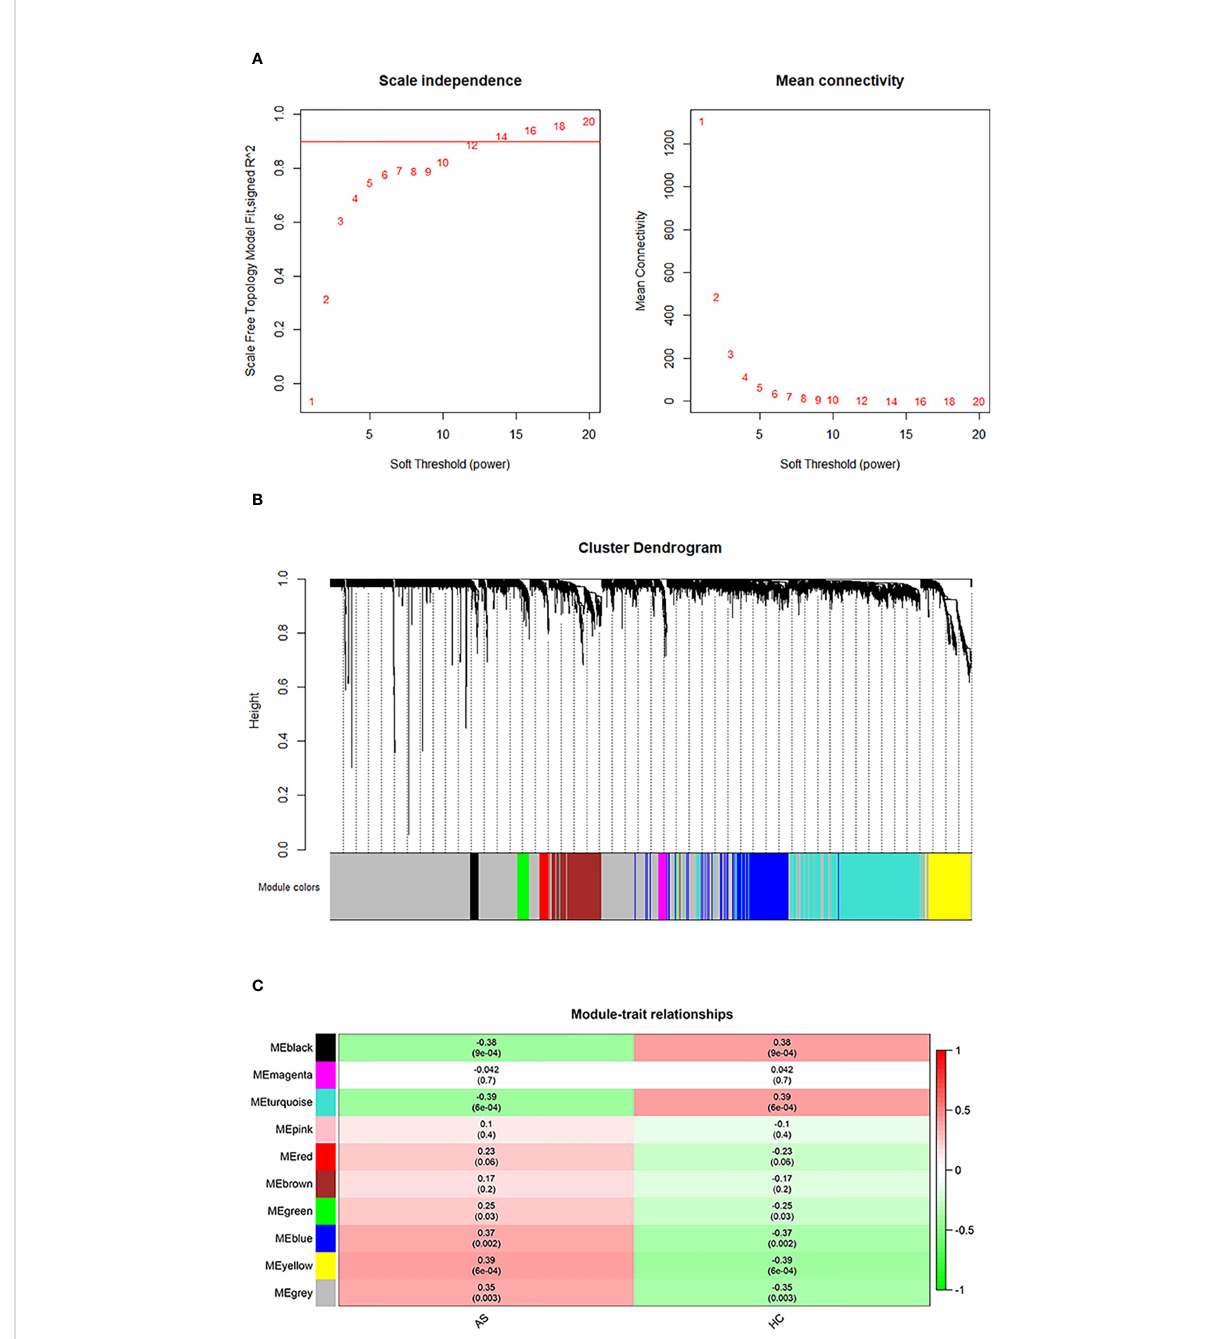
FIGURE 1 WGCNA analysis. (A) Determination of an optimal soft-thresholding power b by calculating the scale-free topology mode fi t and mean connectivity. (B) The cluster dendrogram of mRNAs in GSE73754, revealing different mRNA co-expression modules marked with colors. (C) The heatmap for module-traits relationships, in which the correlation of different modules with AS or HC, P-values are presented in each